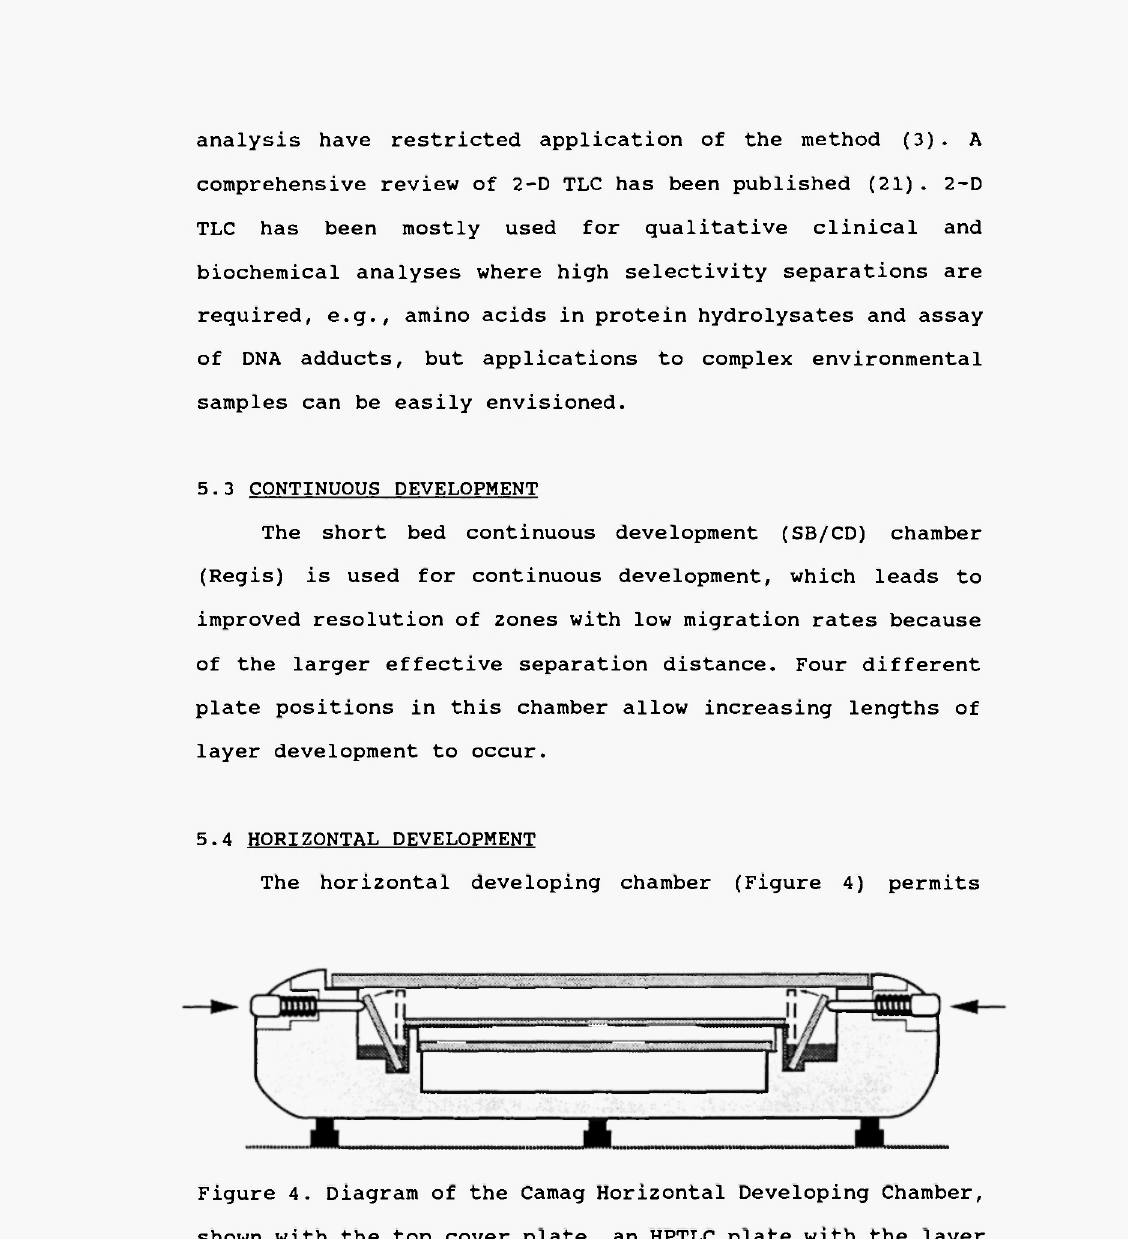
Figure 4. Diagram of the Camag Horizontal Developing Chamber, shown with the top cover plate, an HPTLC plate with the layer facing downward, and a counterplate below for operation in the sandwich configuration. As shown by the arrows, chromatography is begun by tilting the glass strips, dipping into solvent in the troughs, inwards to contact both ends of the